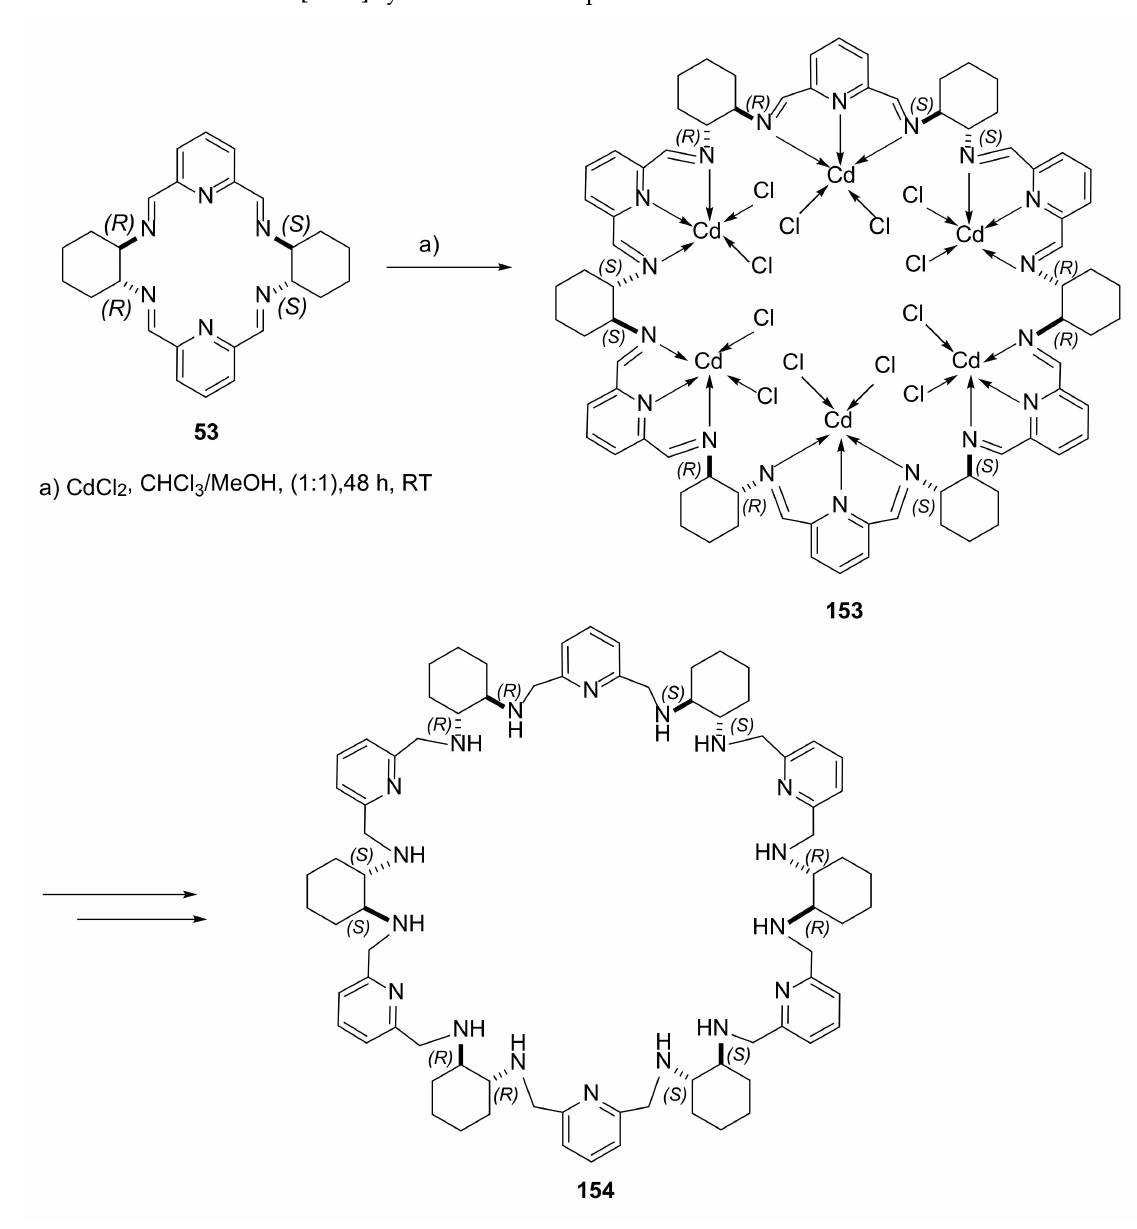
Figure 31. Cadmium-templated polyimine macrocycle ring